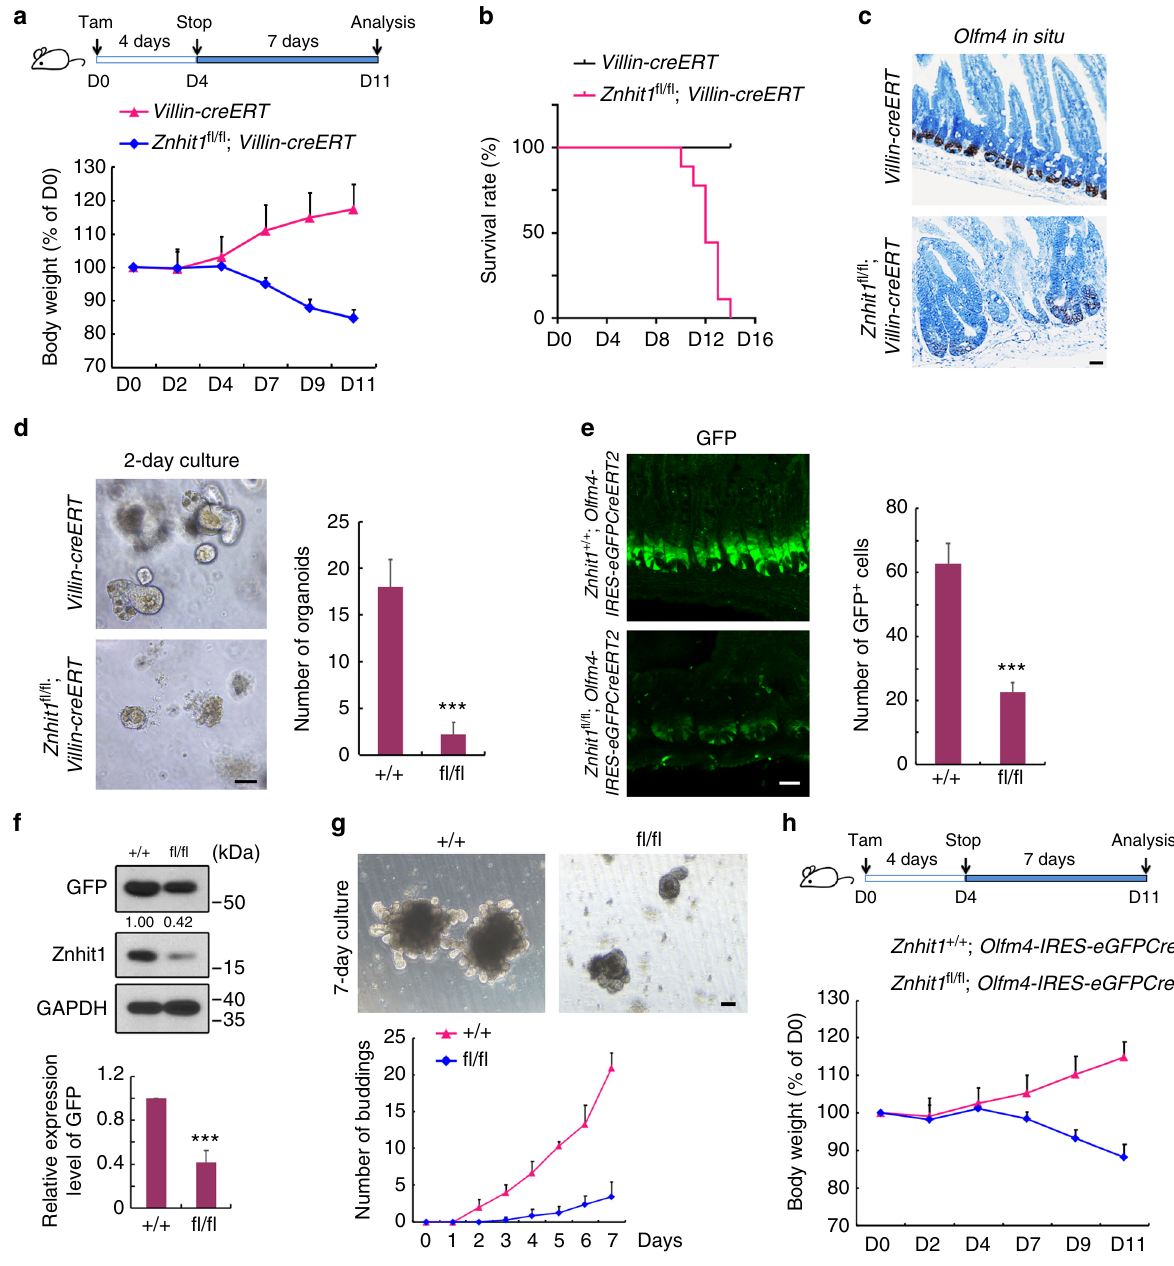
Fig. 2 Znhit1 is essential for Lgr5 + ISC maintenance thus intestinal homeostasis. a Eight-week-old Villin-creERT and Znhit1 fl / fl ; Villin-creERT mice were daily injected with tamoxifen for 4 days followed by 7-day waiting period. Top: Scheme of Cre induction strategy. Bottom: Body weight comparison between Villin-creERT and Znhit1 fl / fl ; Villin-creERT mice at indicated time following tamoxifen treatment. ( n = 5 mice per genotype). b Kaplan – Meier survival curves of Villin-creERT and Znhit1 fl / fl ; Villin-creERT mice post tamoxifen administration ( n = 9 mice per genotype). c Olfm4 in situ was performed in intestinal sections from Villin-creERT and Znhit1 fl / fl ; Villin-creERT mice following tamoxifen treatment. d Intestinal crypts were isolated from Villin-creERT and Znhit1 fl / fl ; Villin- creERT mice following tamoxifen treatment, embedded in Matrigel (100 crypts per well) and cultured for 2 days. The statistical analysis of organoid numbers ( n = 3 mice per genotype) was shown. e Eight-week-old Znhit1 + / + ; Olfm4-IRES-eGFPCreERT2 and Znhit1 fl / fl ; Olfm4-IRES-eGFPCreERT2 mice were daily injected with tamoxifen for 3 days followed by 4-day waiting period, then Lgr5 + ISCs were examined by confocal cross-sectioning. The GFP + cells were quanti fi ed for statistical analysis ( n = 3 mice per genotype). f Intestinal crypts were isolated from Znhit1 + / + ; Olfm4-IRES-eGFPCreERT2 ( + / + ) and Znhit1 fl / fl ; Olfm4-IRES-eGFPCreERT2 ( fl / fl ) mice following tamoxifen treatment for immunoblotting with the indicated antibodies. GAPDH served as a loading control. The statistical data represent mean + s.d. ( n = 3 mice per genotype). g Intestinal crypts were isolated from Znhit1 + / + ; Olfm4-IRES- eGFPCreERT2 ( + / + ) and Znhit1 fl / fl ; Olfm4-IRES-eGFPCreERT2 ( fl / fl ) mice following tamoxifen treatment, embedded in Matrigel (100 crypts per well) and cultured for 7 days. The organoid buddings were quanti fi ed for statistical analysis ( n = 5 mice per genotype). h Znhit1 + / + ; Olfm4-IRES-eGFPCreERT2 and Znhit1 fl / fl ; Olfm4-IRES-eGFPCreERT2 mice were daily injected with tamoxifen for 4 days followed by 7-day waiting period. Body weight comparison was shown ( n = 3 mice per genotype). The statistical data represent mean ± s.d. Student ’ s t -test: *** P < 0.001. All images are representative of n = 3 mice